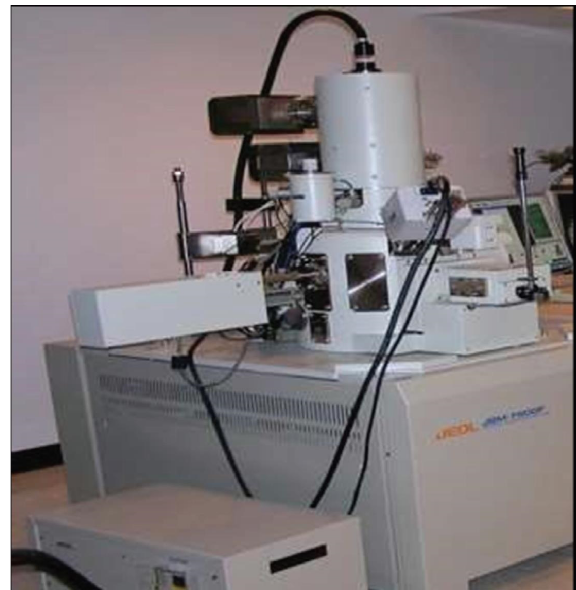
Figure 4: Scanning electron microscope